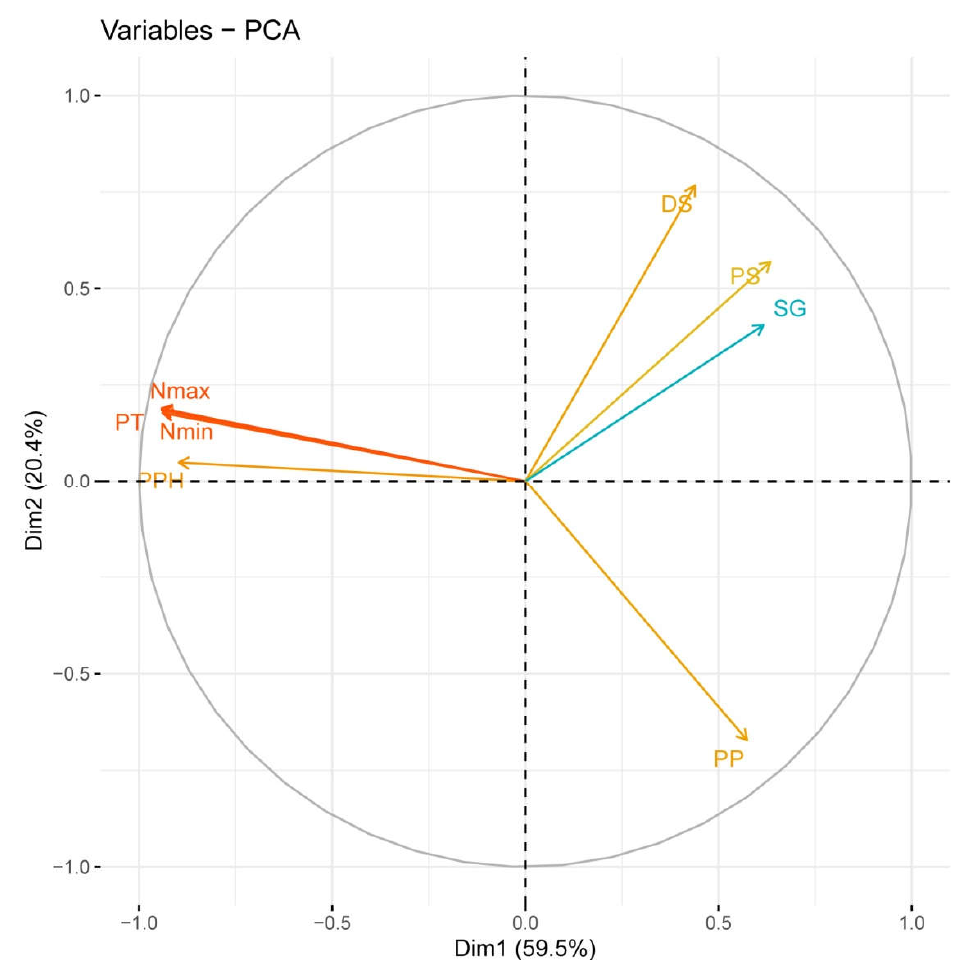
Figure 4. Relative contribution of the original variables to the first two PCs for the multivariate analysis. The percentage of variance explained by each principal component is indicated.